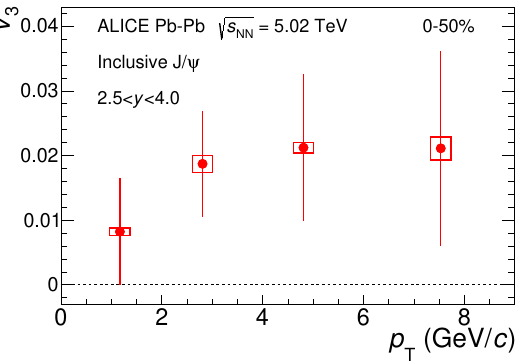
Figure 5 . (Color online) The J/ v 3 coe(cid:14)cient as a function of p T in the 0{50% centrality interval p in Pb-Pb collisions at s NN = 5.02 TeV. Statistical and systematic uncertainties are shown as bars and boxes, respectively.